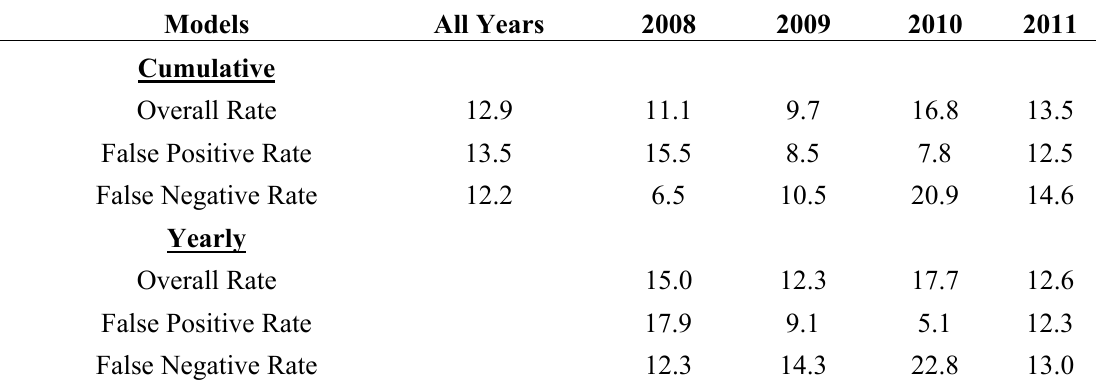
Table 2. Misclassification rates (% of total observations) for the validation dataset used to test the binary classification trees predicting cattle activity (grazing vs. not grazing) for all 4 years of data combined (cumulative model) and for each year modeled